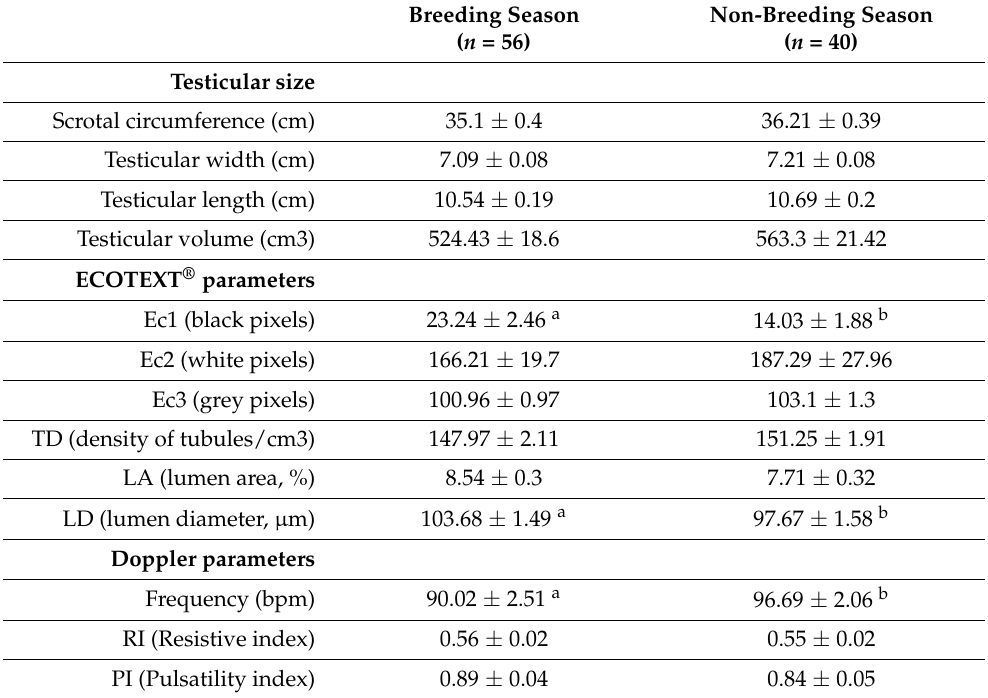
Table 1. Seasonal differences in testicular size, echotexture parameters (evaluated by ultrasound- video analysis and ECOTEXT ® software) and testicular-artery blood flow (assessed by color-Doppler flow imaging) in Rasa Aragonesa rams. Results are shown as mean ± SEM. Different letters indicate p <